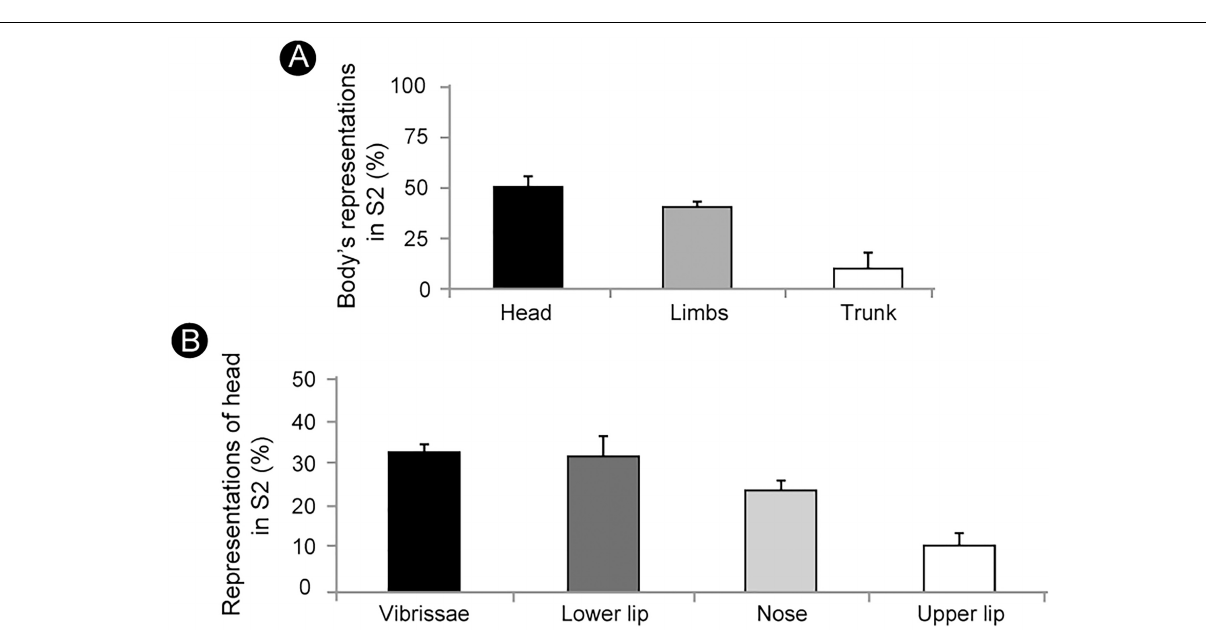
Within the representation of the head the larger portion is devoted to the vibrissae (33%) and the lower lip (32%), while the nose and the upper lip occupy 24% and 11% of the area, respectively ( Figure 5B ) (mean values from five electrophysiological